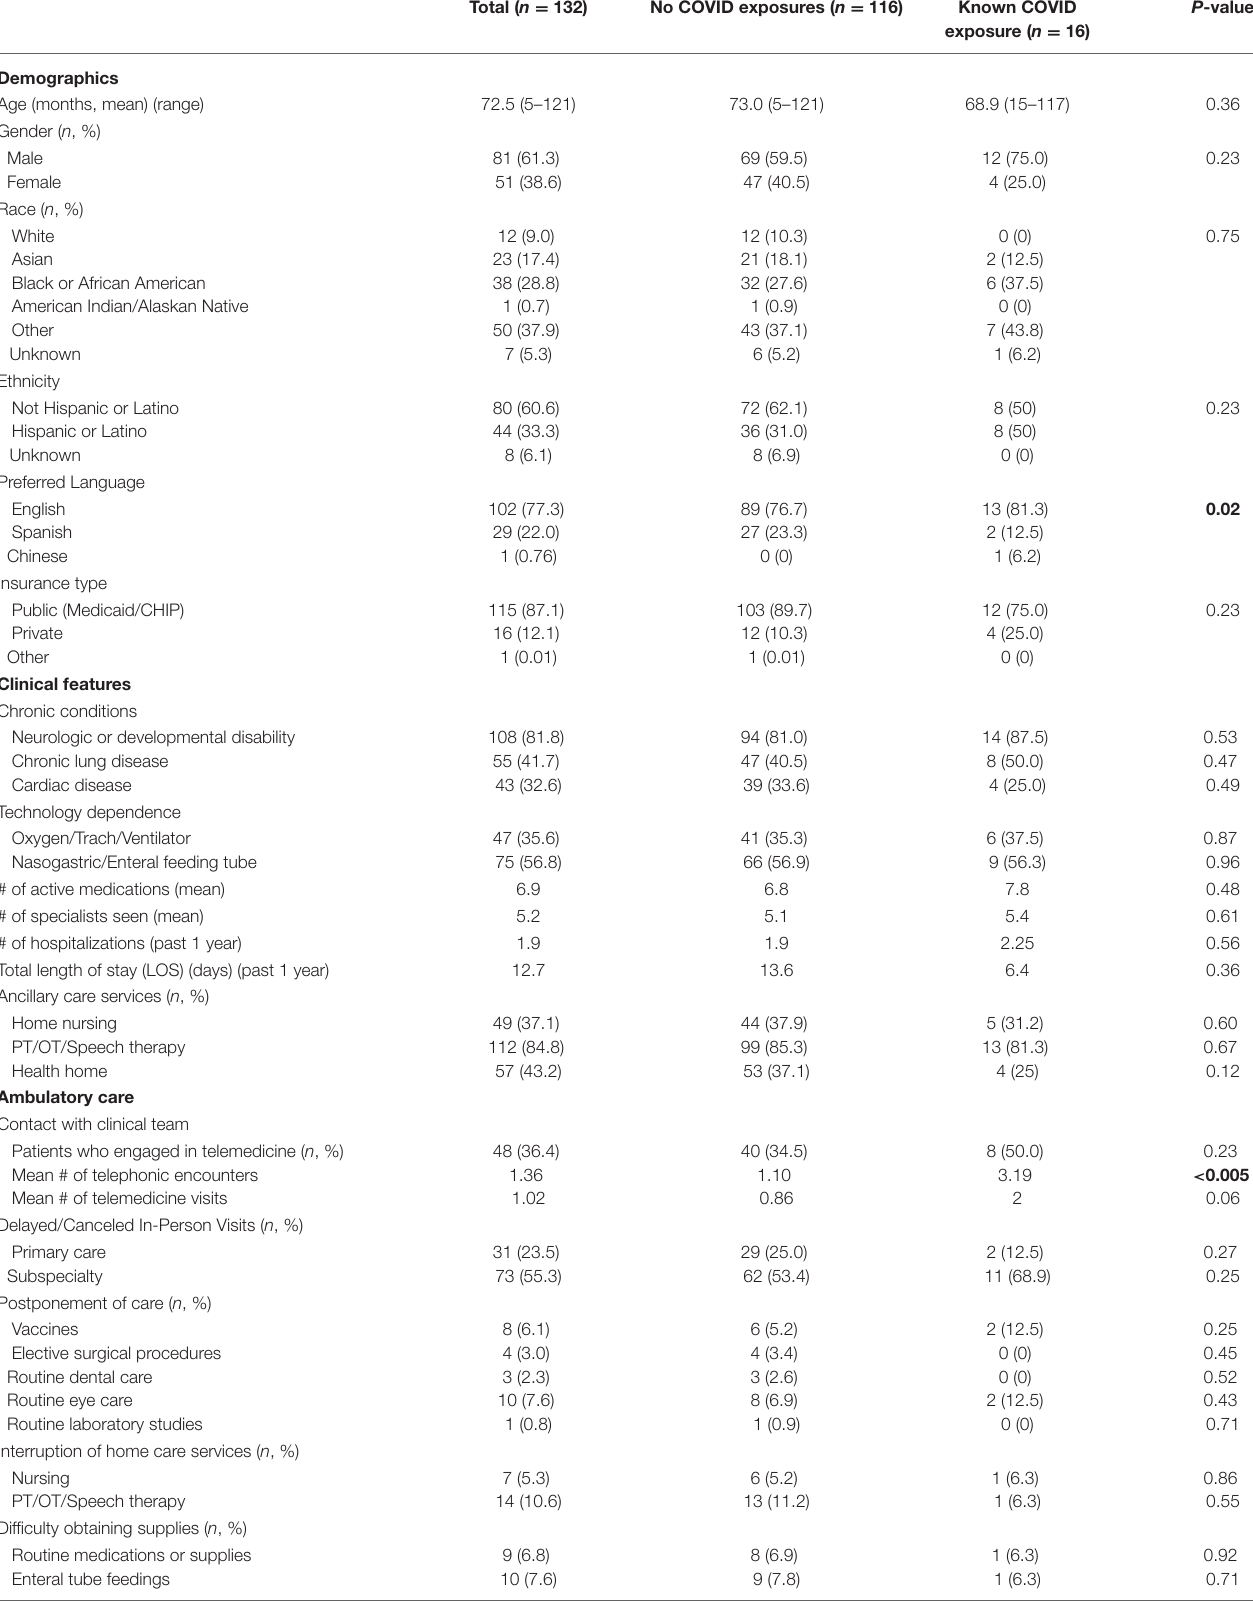
TABLE 1 | Demographic and clinical features of patient